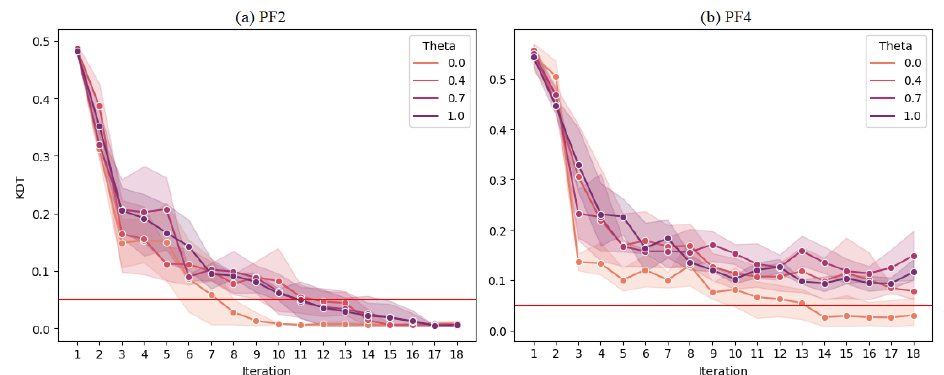
Figure 6. Effects of varying θ in problems PF2 in ( a ) and PF4 in ( b ), whose Pareto surfaces are